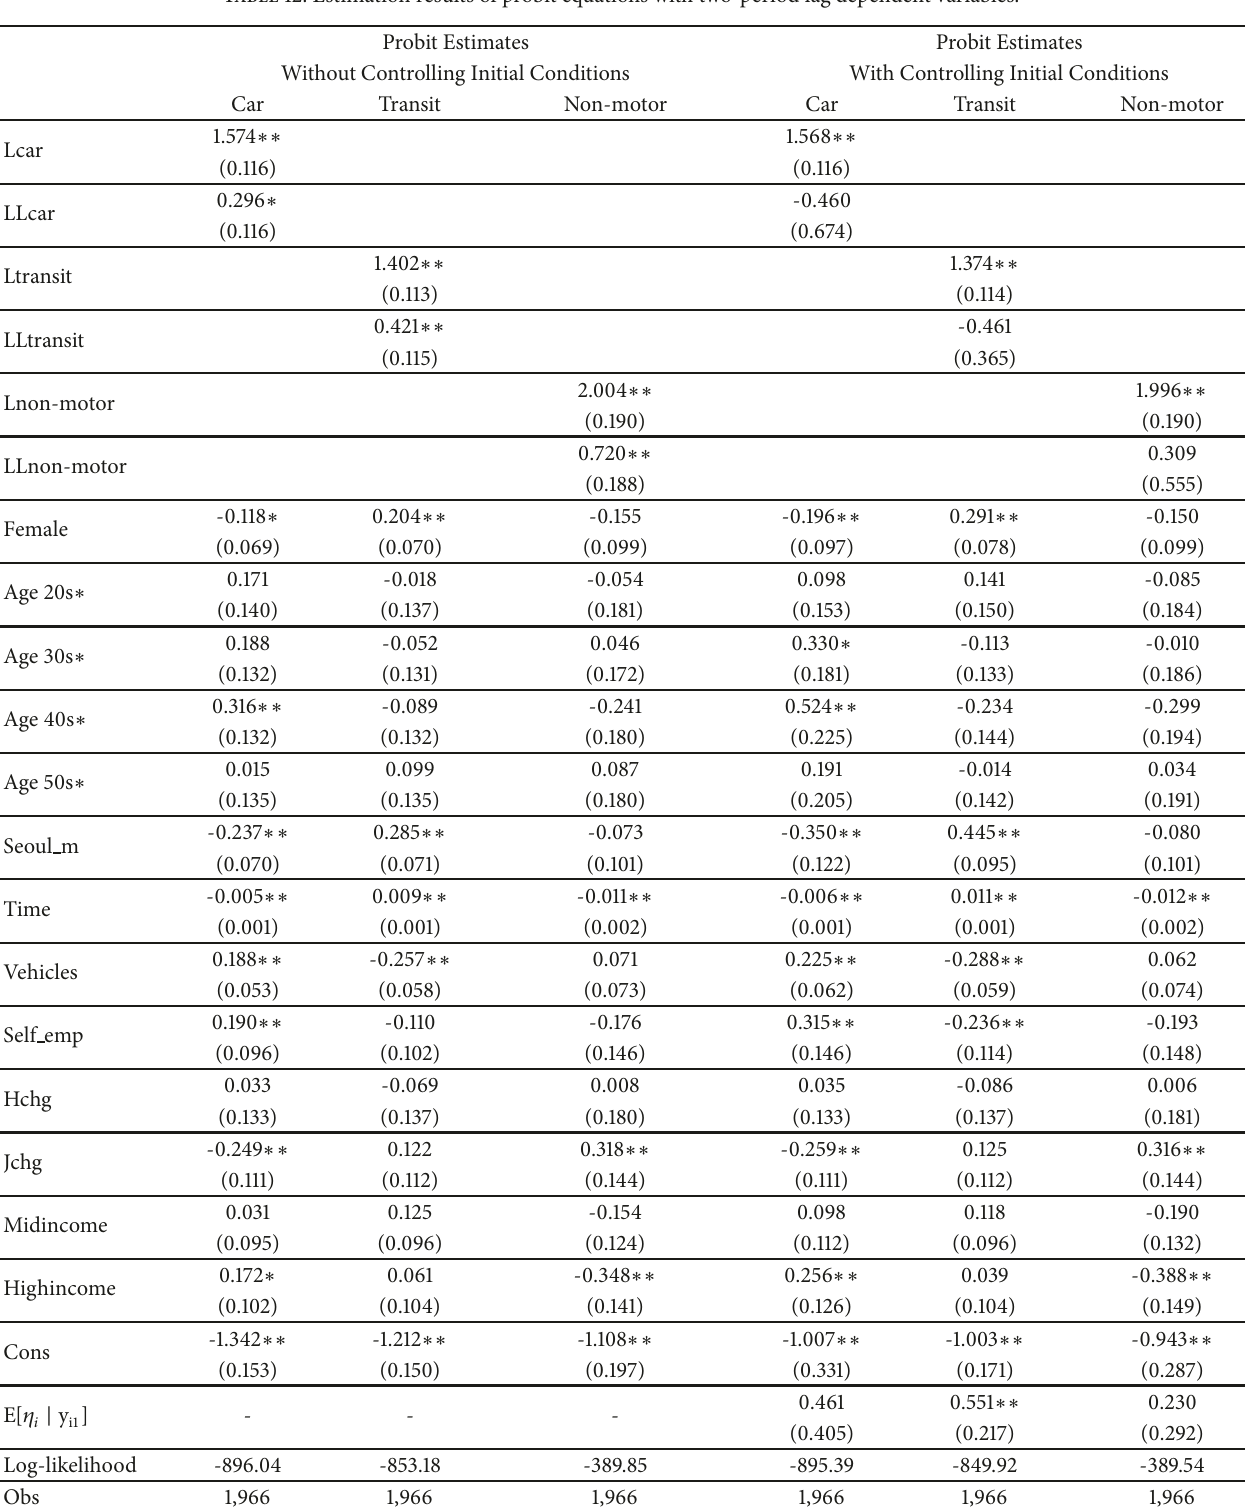
Table 12: Estimation results of probit equations with two-period lag dependent